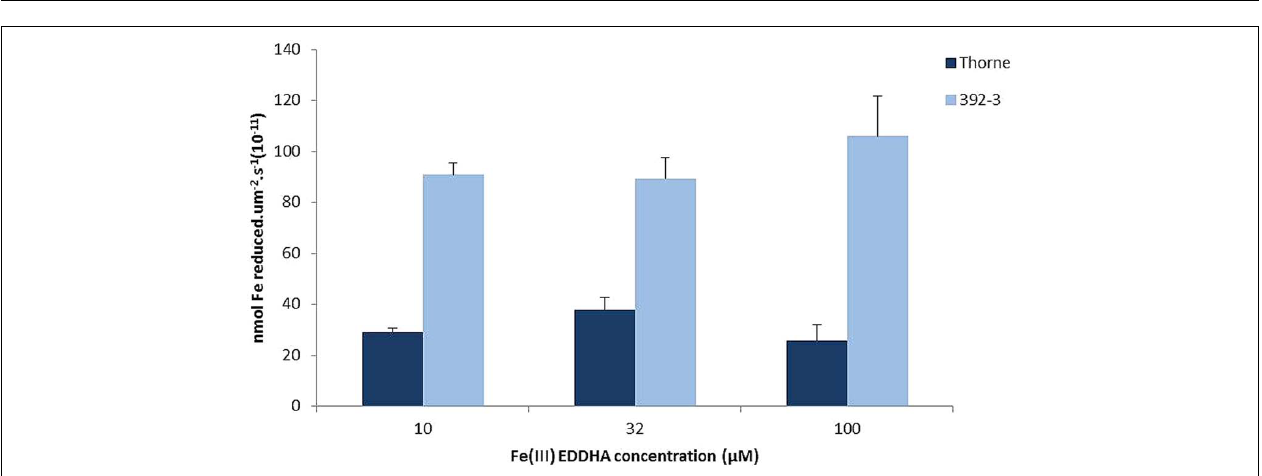
FIGURE 7 | Mineral correlation analysis. Pearson’s correlation analysis of ten mineral concentrations in leaves (A) , pod walls (B) , and seeds (C) of Thorne and 392-3 soybean plants cultivated with 10, 32, or 100 μ M of Fe (III)-EDDHA and measured at two grain filling stages (GF I and GF II) or at full maturity (FM). Solid lines represent a significant positive